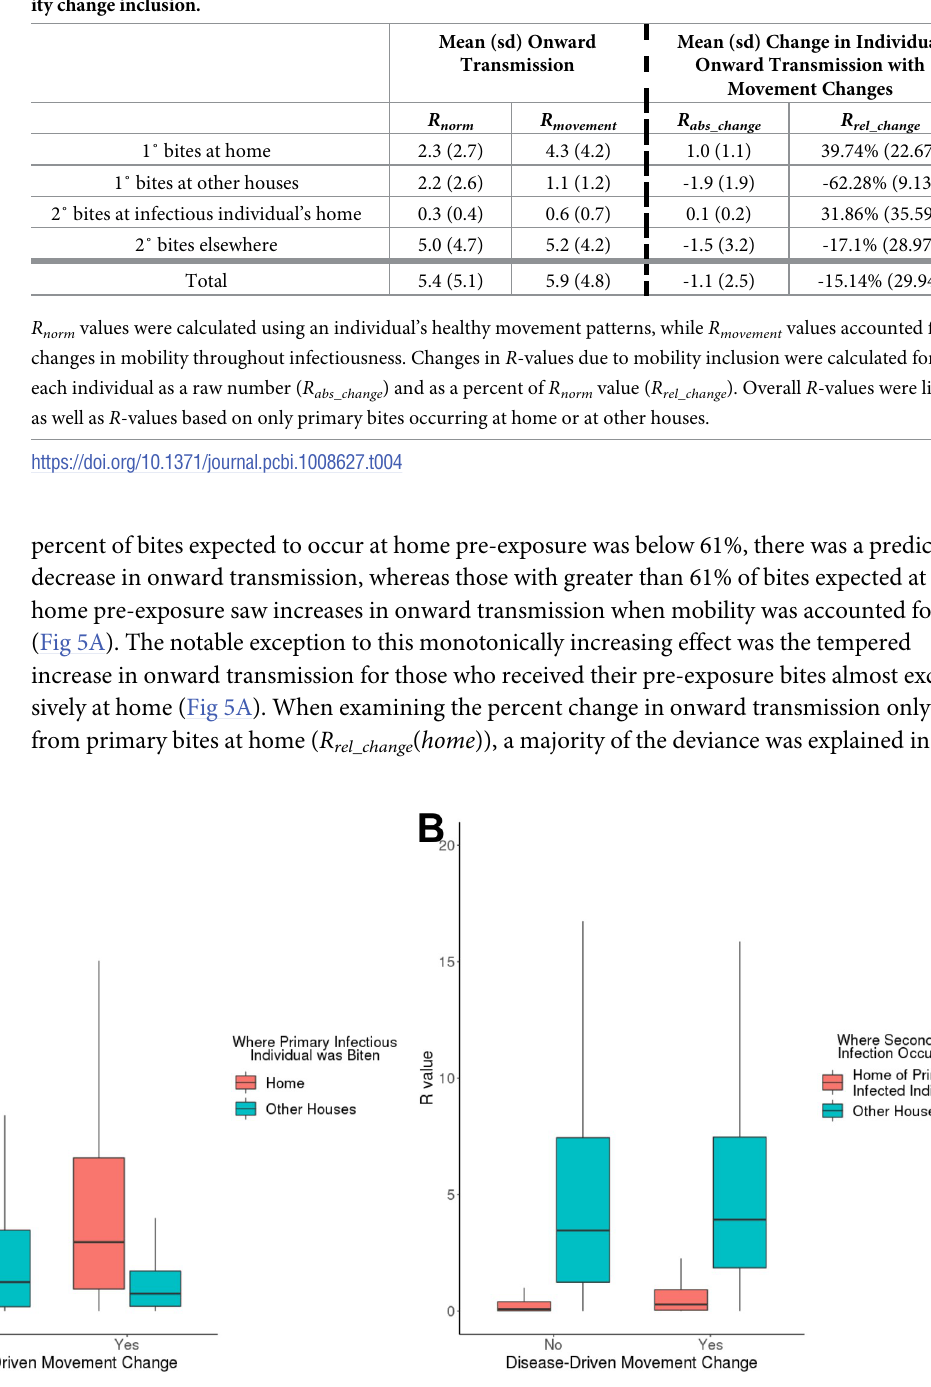
Table 4. Average onward transmission ( R ) values with and without mobility change and change in R due to mobil- ity change inclusion.